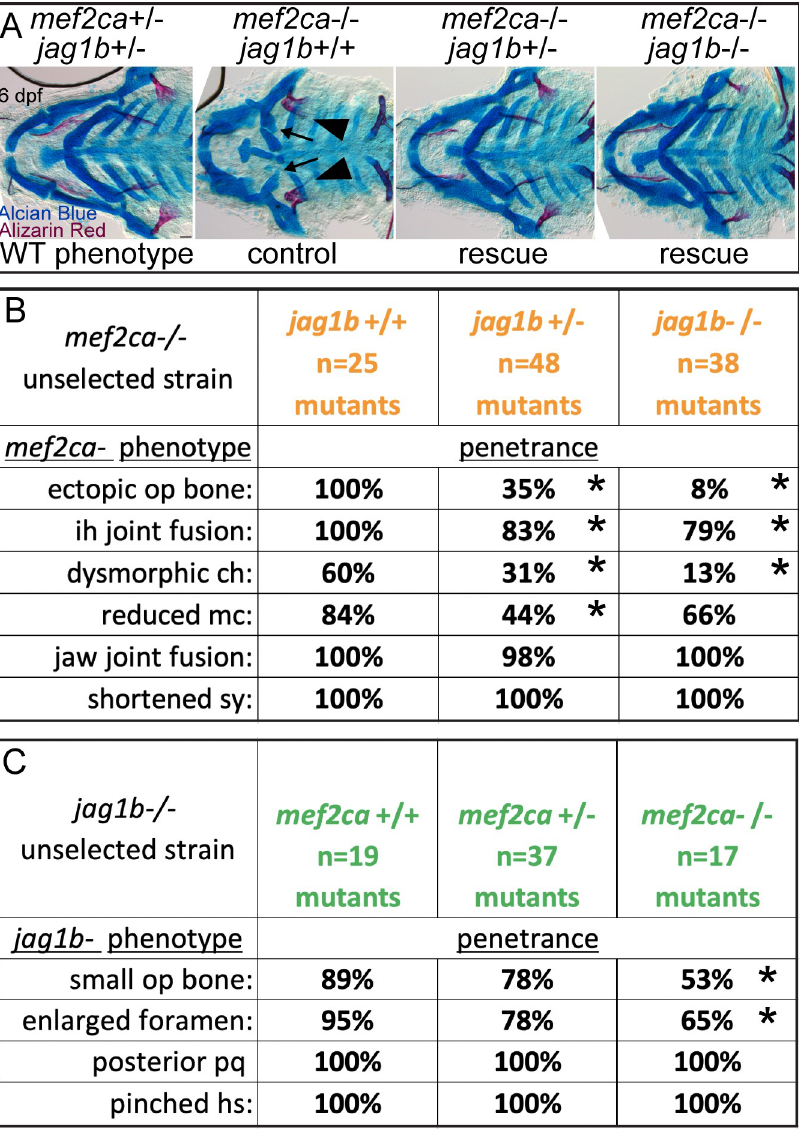
Fig 9. Loss of jag1b function decreases the penetrance of mef2ca -associated phenotypes. (A) Animals double heterozygous for mef2ca and jag1b were intercrossed, raised to 6 dpf and fixed and stained with Alcian Blue (cartilage) and Alizarin Red (bone). Genotyped animals were flat mounted and imaged. Removing functional copies of jag1b decreased mef2ca mutant penetrance. Scale bar: 50 μ m. (B) Genotyped mef2ca;jag1b skeletal preparations were scored for penetrance of mef2ca -associated phenotypes. Asterisks indicate significance at alpha = 0.05 Fisher’s exact test compared with jag1b+/+ . (C) Genotyped mef2ca;jag1b skeletal preparations were scored for penetrance of jag1b - associated phenotypes. Asterisks indicate significance at alpha = 0.05 Fisher’s exact test compared with mef2ca+/+ .